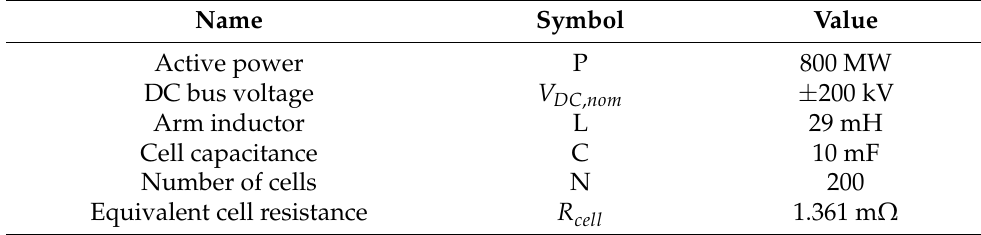
Table 1. Electrical characteristics of the HVDC